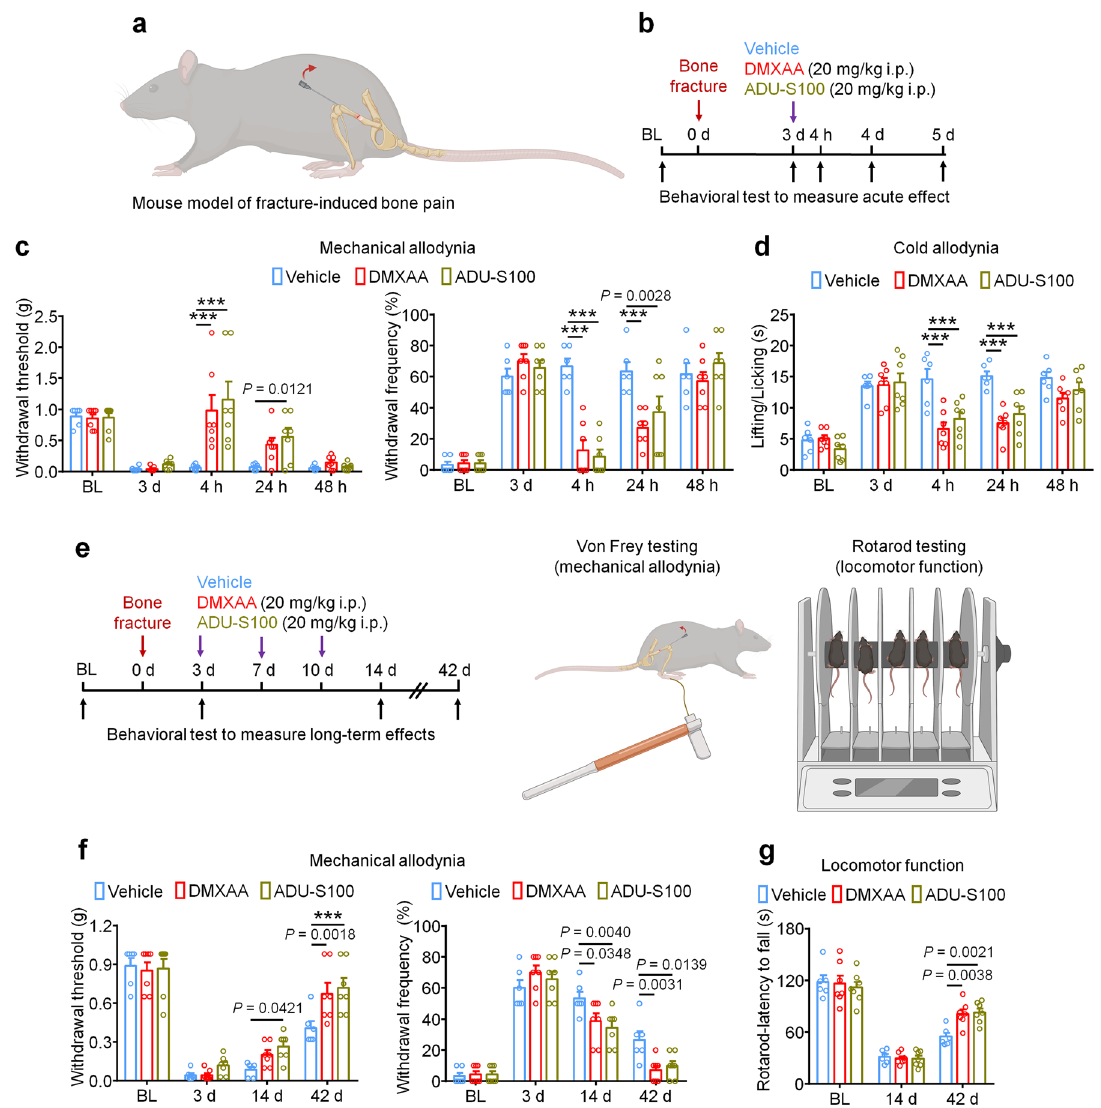
Fig. 9 STING agonists reduce fracture-induced bone pain in tumor-free mice. a Schematic of mouse model of fracture-induced bone pain. b Experimental diagram indicating single treatment of vehicle, DMXAA, or ADU-S100 and behavioral testing. c , d Mechanical allodynia from von Frey test ( c ) and cold allodynia from acetone test ( d ) in mice treated with vehicle, DMXAA, or ADU-S100 (20 mg/kg i.p.) on d3 after bone fracture, *** P < 0.001. e Experimental diagram of repeated administration of vehicle, DMXAA, or ADU-S100 and behavioral testing for the measurement of long-term effects. f Von Frey test to determine mechanical allodynia, as assessed by withdrawal threshold (left) or withdrawal frequency (right) in mice treated with vehicle, DMXAA or ADU- S100 (3 × 20 mg/kg, i.p.) at d14 and d42 after bone fracture, *** P < 0.001. g Locomotor function of mice treated with vehicle, DMXAA or ADU-S100 (3 × 20 mg/kg, i.p.) at d14 and d42 after injury. Sample sizes for c , d , f , and g were as follows: n = 6 vehicle-treated mice, n = 7 DMXAA-treated mice, n = 7 ADU-S100-treated mice. Data are mean ± SEM, repeated-measures two-way ANOVA with Bonferroni ’ s post hoc test ( c , d , f , g ). Source data are provided as a Source Data fi